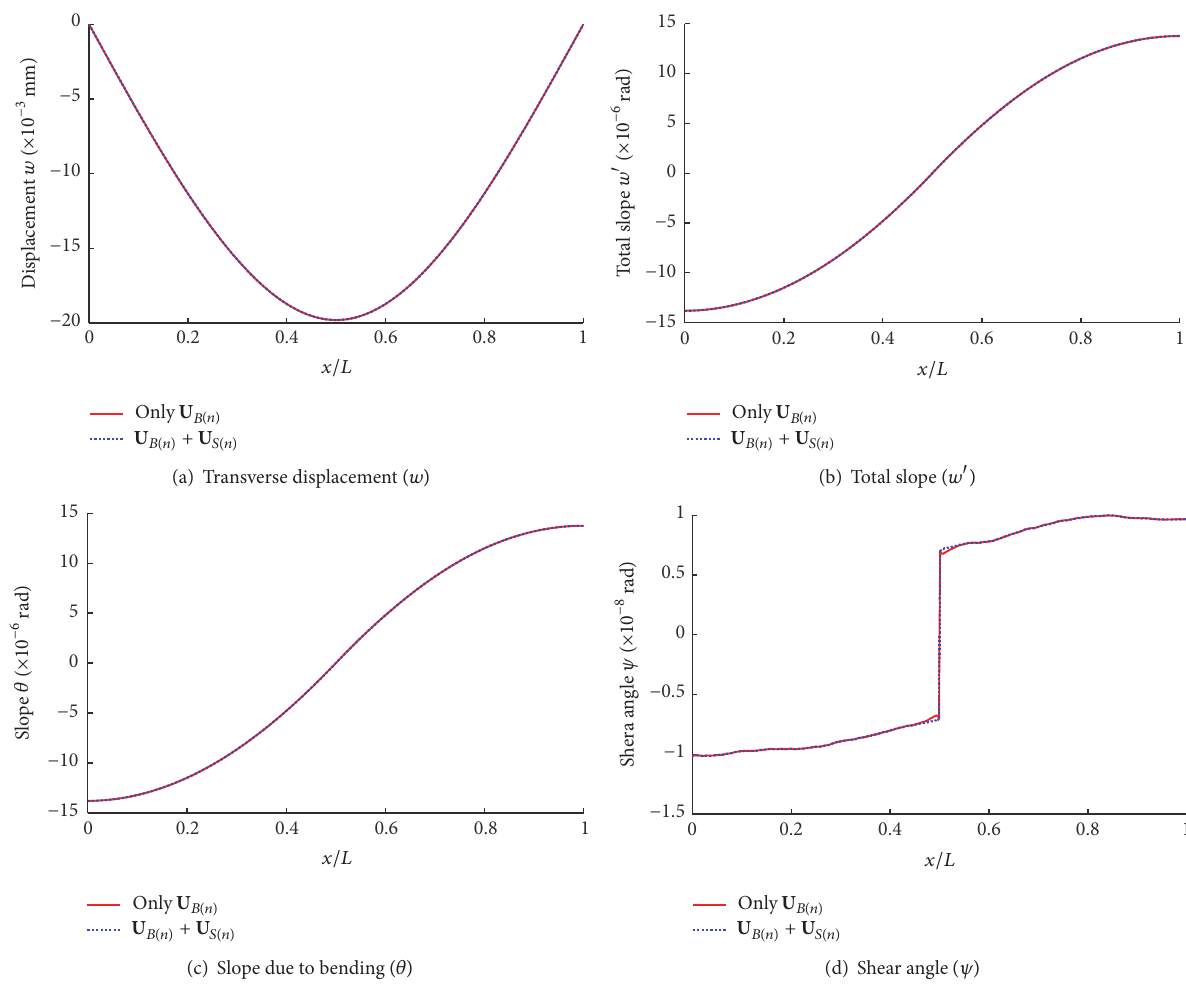
Figure 7: Deformed shapes of a simply supported Timoshenko beam at 𝑡 = 0.5𝑇 𝐴 when the beam is subjected to a point transverse force moving at a constant speed of V 𝑓 = 0.5 V cr : (a) transverse displacement (𝑤) ; (b) total slope (𝑤 󸀠 ) ; (c) slope due to bending (𝜃) ; (d) shear angle (𝜓)